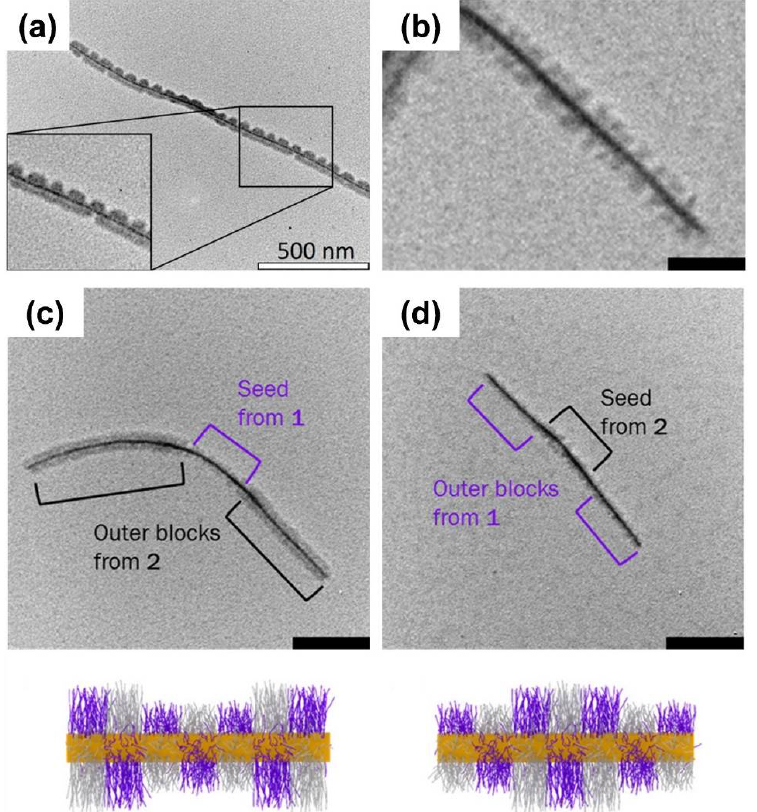
Figure 7. ( a ) Patchy micelles formed by CDSA of a µ -SIF (polystyrene– arm –polyisoprene– arm– poly(ferrocenyl dimethylsilane)) miktoarm star terpolymer in ethyl acetate. ( b ) Patchy cylindrical micelles and ( c , d ) patchy ABA-type triblock co-micelles with a crystalline PFS core and a patchy PS/PMMA corona prepared in acetone (scale bars = 100 nm). In ( c , d ), triblock terpolymers with PS and PMMA blocks of different lengths were used to alter the width of the patchy corona in the middle and outer blocks of the triblock co-micelles (in the sketches PS is depicted in light grey and PMMA in purple). ( a ) Reprinted from [142], and ( b – d ) from [140] with permission of ACS.